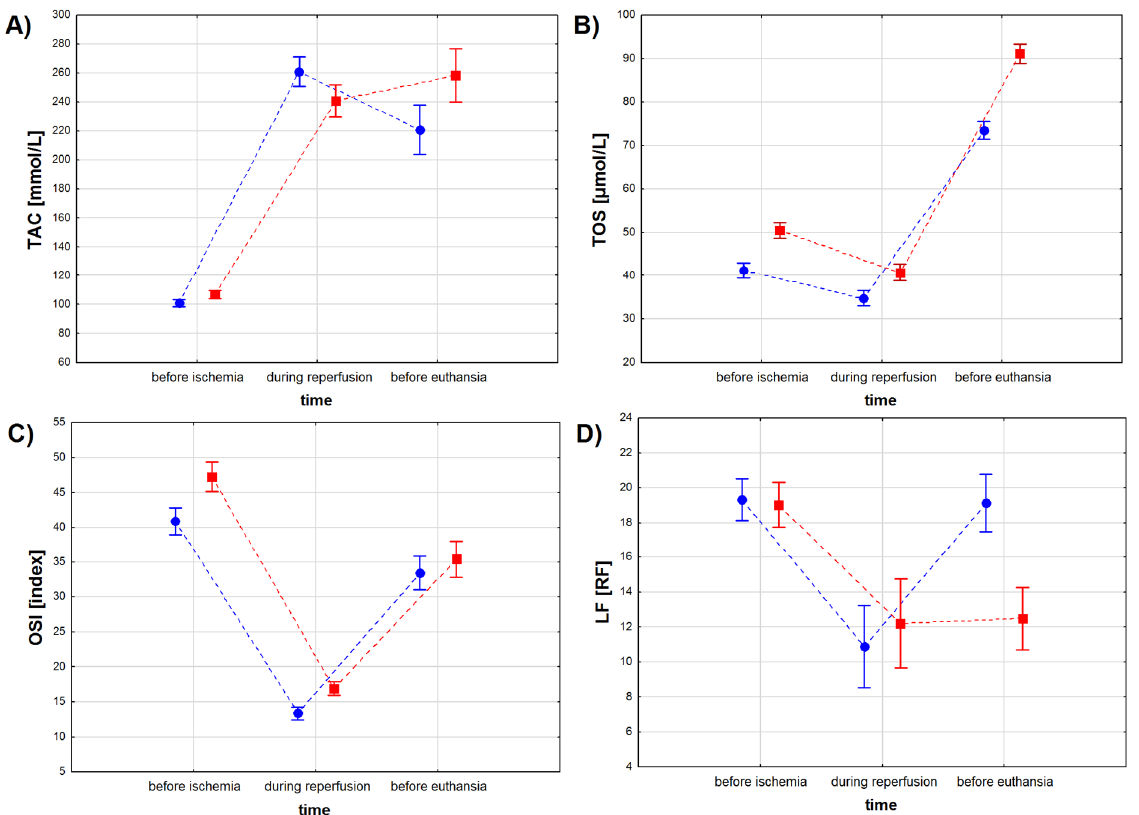
Figure 3. Oxidative stress marker levels in the serum of pigs subjected to a myocardial ischemia- reperfusion protocol assessing the effectiveness of intracoronary administered acetylsalicylic acid (ASA): ( A ) total antioxidant capacity (TAC) [mmol/L], ( B ) total oxidative status (TOS) [µmol/L], ( C ) oxidative stress index (OSI) [index] and ( D ) lipofuscin (LF) concentration [RF]. The results are presented as mean ± 95% confidence interval and, for the reader’s convenience, the points are connected with dashed lines.